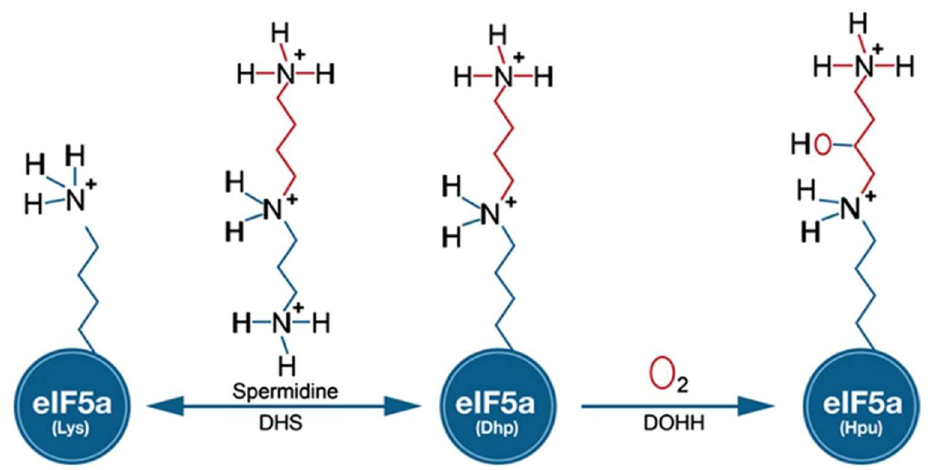
Figure 1. Biochemical pathway leading to the formation of hypusine in EIF5A protein: In the first step of the pathway, DHS transfers an aminobutyl moiety from the substrate spermidine to a specific lysine residue in the EIF5A precursor protein to form deoxyhypusine. In the second step, deox- yhypusine hydroxylase (DOHH) completes hypusine biosynthesis, introducing a hydroxyl group into the side chain.